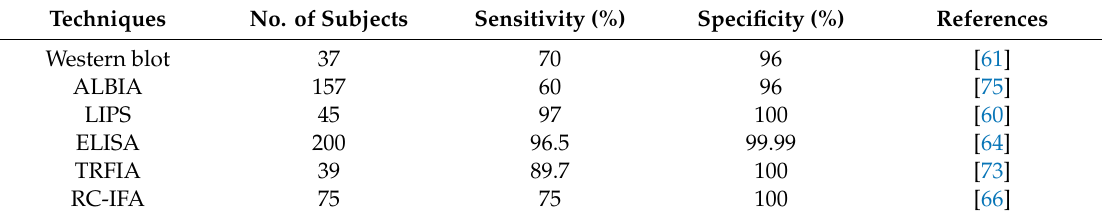
Table 1. Showing various techniques used in detecting PLA 2 R